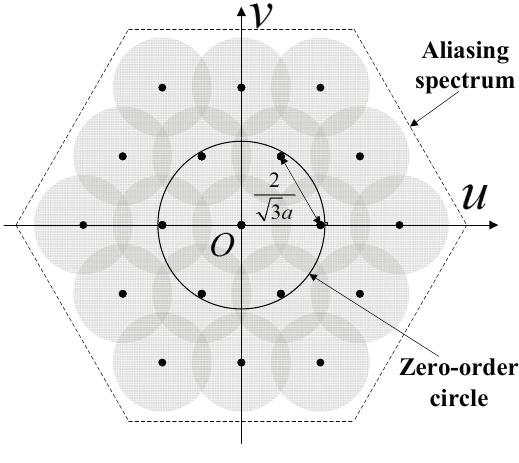
Figure 6. Overlapping frequency points in the frequency